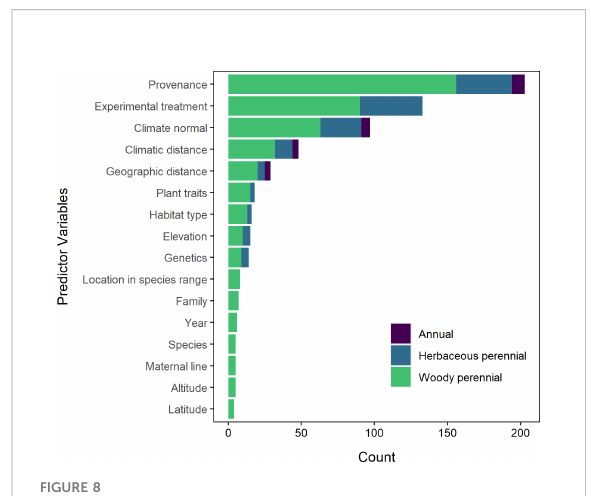
FIGURE 8 Predictor variables by plant life cycle. Predictors by life cycle pairs represented by two or fewer studies, as well as a single study of an herbaceous perennial, are omitted from this visualization. The most common predictor variables seen in statistical analyses were the provenance (or site of origin), followed by the experimental treatment or study site. However, this trend is largely driven by studies of woody perennials. Studies of woody perennials also appear to consider a greater diversity of predictor variables than studies of herbaceous perennials and annual plants.